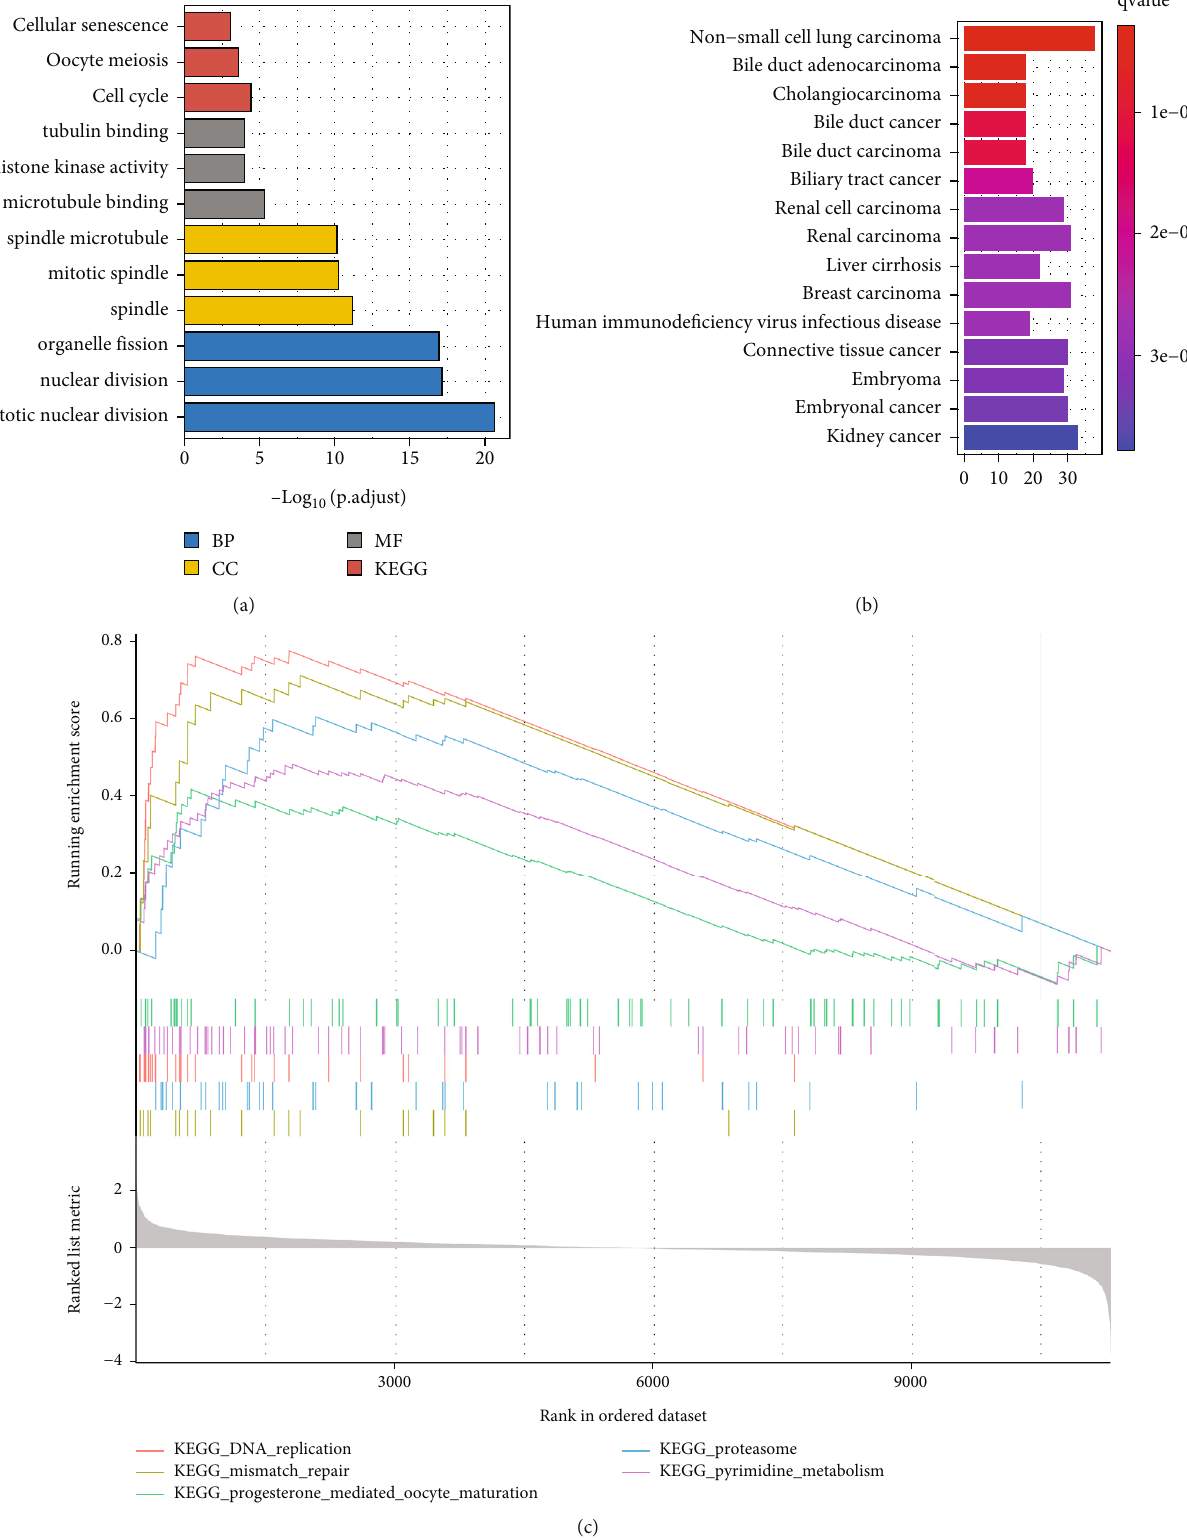
Figure 2: Functional enrichment analysis. (a) GO and KEGG functional enrichment analyses of the DEGs. (b) Disease Ontology enrichment analysis of the DEGs between HCC and control samples. (c) Enriched gene set enrichment analysis (GSEA) terms between HCC and